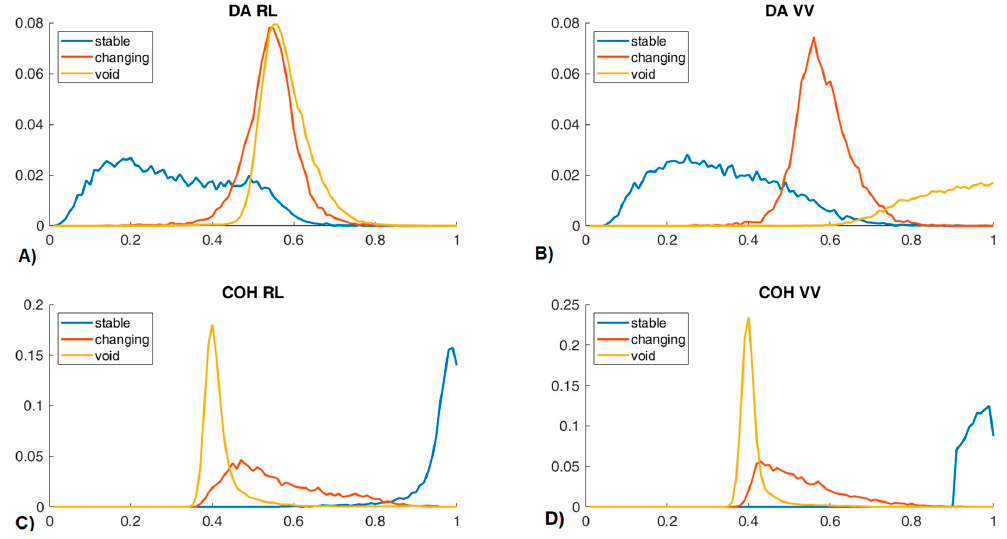
Figure 23. PDF calculated for the three classes: ( A ) DA RL, ( B ) DA VV, ( C ) COH RL, and ( D ) CO VV.